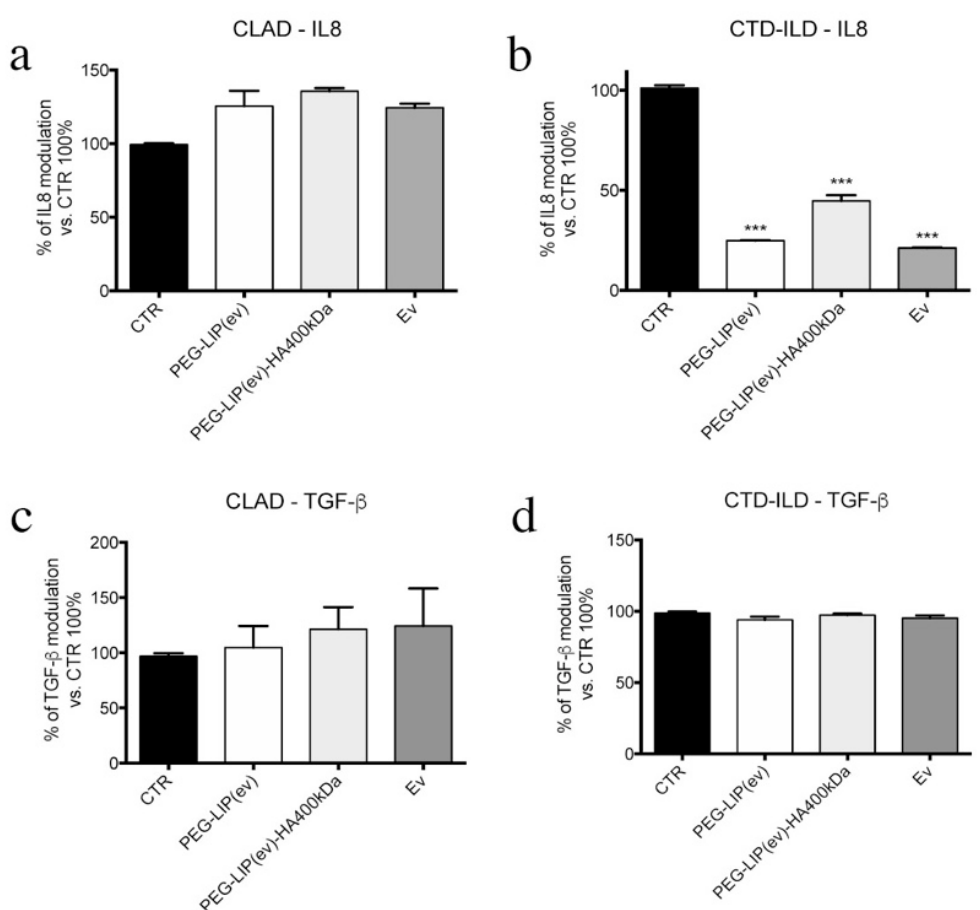
Figure 9. Effect on IL8 and TGF- β release by AM after 48 h of treatments (final concentration of everolimus = 50 nM). ( a , b ) IL8 quantification of AM derived from BAL of ( a ) CLAD or ( b ) CTD-ILD. ( c , d ) TGF- β quantification of AM derived from BAL of ( c ) CLAD or ( d ) CTD-ILD. Data have been normalized to control cells (100%) and are represented as mean ± SD. ***, p < 0.001 vs. CTR.